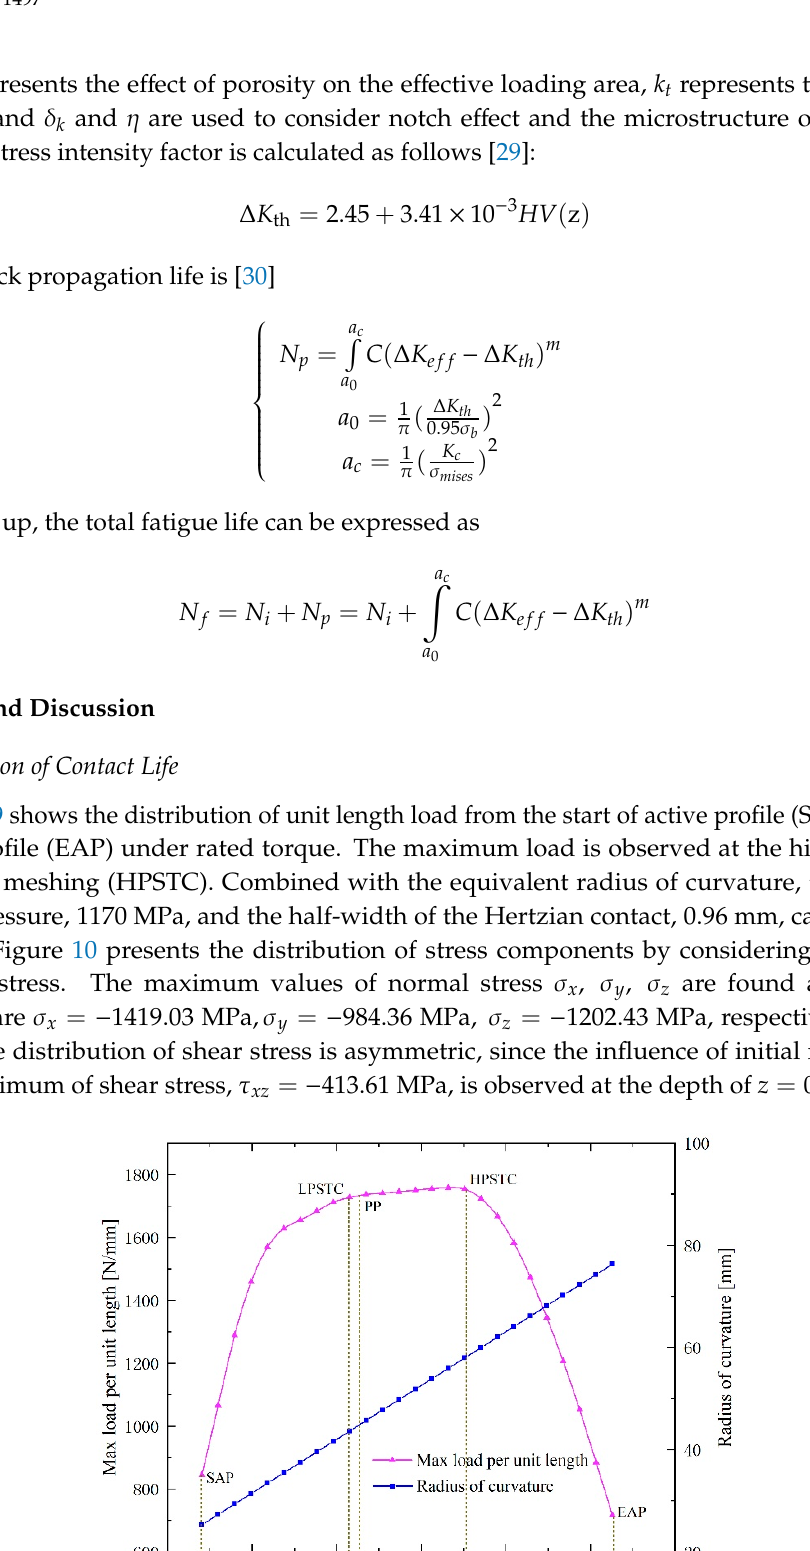
Figure 10. The distributions of stress components incorporating initial residual stress. The profiles of fatigue parameter and life along the depth direction is shown in Figure 11. The maximum fatigue parameter is 0.38 at the depth of 𝑧 = 1 mm . The corresponding fatigue life is 1.284 × 10 (cid:2869)(cid:2870) , and the crack propagation life is 5.828 × 10 (cid:2873) . With the decrease of fatigue parameters, the predicted life is increased gradually.